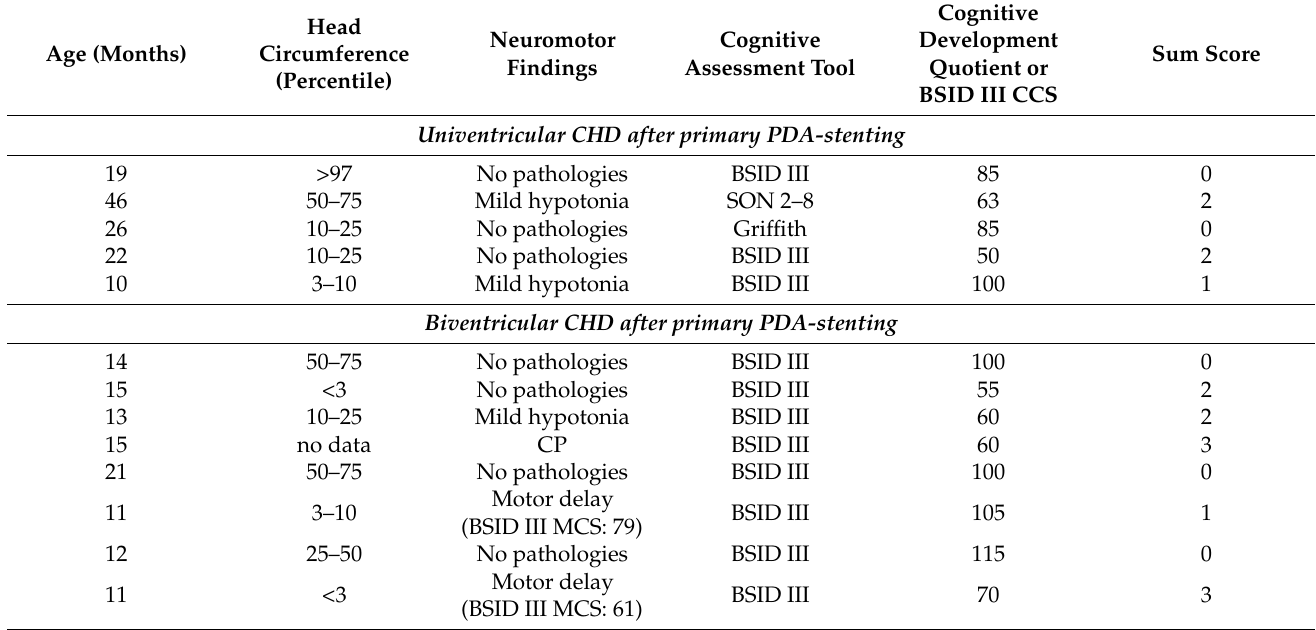
Table 3. Head circumference and neurodevelopmental outcome of infants with complex types of CHD evaluated after primary PDA-stenting and subsequent surgical palliation for univentricular CHD (stage II) or surgical repair for biventricular CHD for short- to mid-term